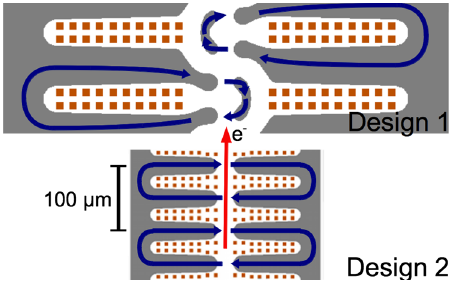
FIG. 3. Illustration of a two period cross section of two un- ¼ 100 (cid:1) m . Design 1 allows further dulator designs with (cid:2) u scaling. The magnetic yoke is shown in gray, the solenoid winding interconnect cross sections are shown in orange, and the intended magnetic flux path is shown in